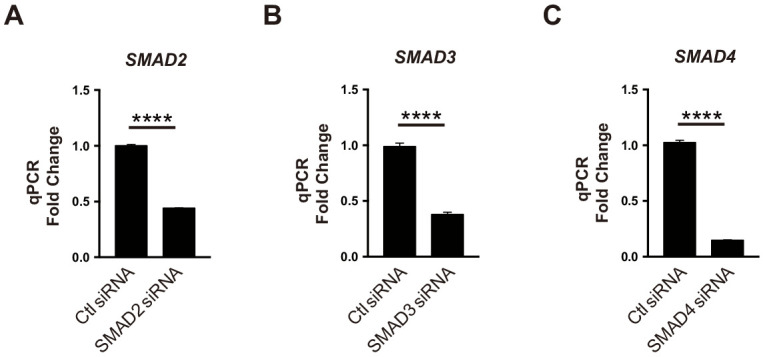
The knockdown efficiency for SMAD siRNA.(A) Knockdown efficiency for (A) SMAD2 siRNA, (B) SMAD3 siRNA, and (C) SMAD4 siRNA compared to siRNA control transfected HUVECs as quantified by real-time qPCR. (A–C), n = 3. ****p<0.0001. All values represent mean ± SEM.